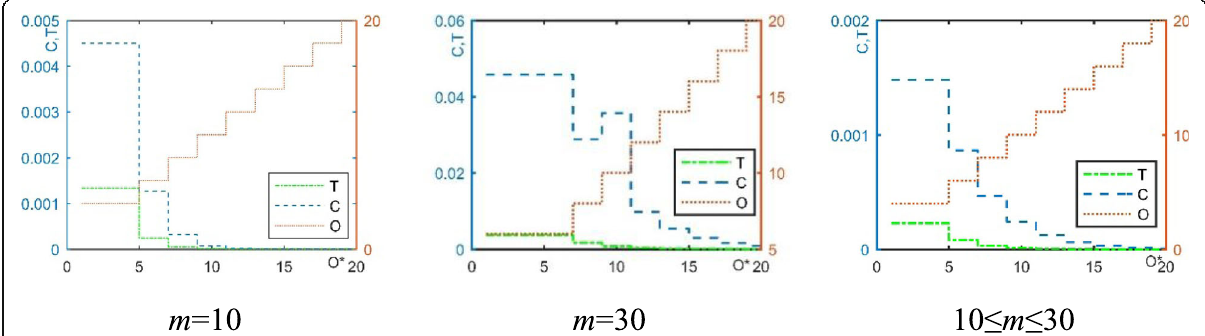
Fig. 8 Relationship among data security, data survivability, and user storage overhead under various O* constraints for n = 50 and C * = 0.05